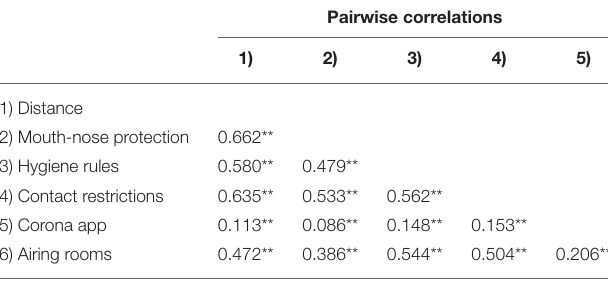
TABLE 2 | Pairwise correlations ( N = 4,096).